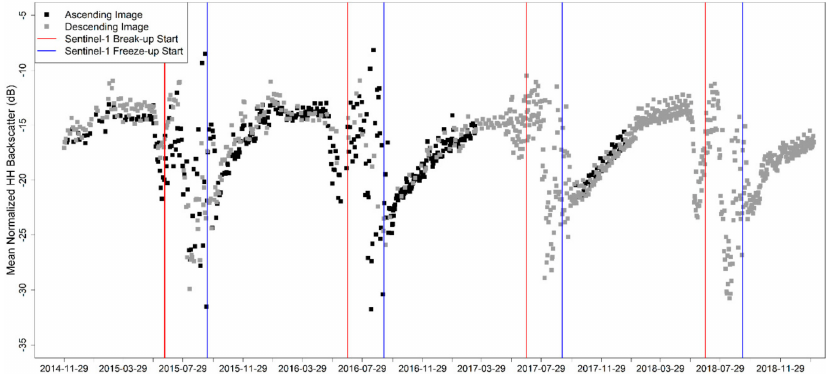
Figure 3. Average backscatter evolution of the high-density time series for all of Lake Hazen from 2015–2018. Ascending and descending images are represented by black and grey squares, while melt and freeze start times determined from Sentinel-1 images are represented by solid red and blue